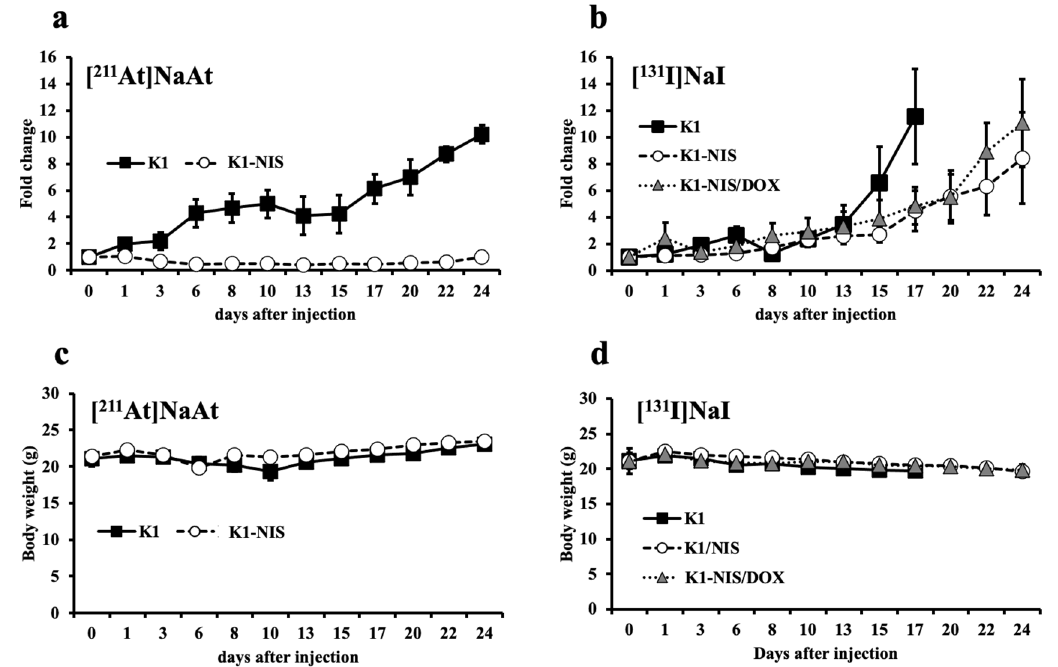
Figure 5. Follow up of tumor bearing model of K1, K1 ‐ NIS, and K1 ‐ NIS/DOX cell treated [ 211 I]NaAt ( a , c ) and [ 131 I]NaI ( b , d ) solutions. Tumor sizes were shown in ( a , b ), and weights were shown in ( c , d ). Data was shown in mean ± S.D.